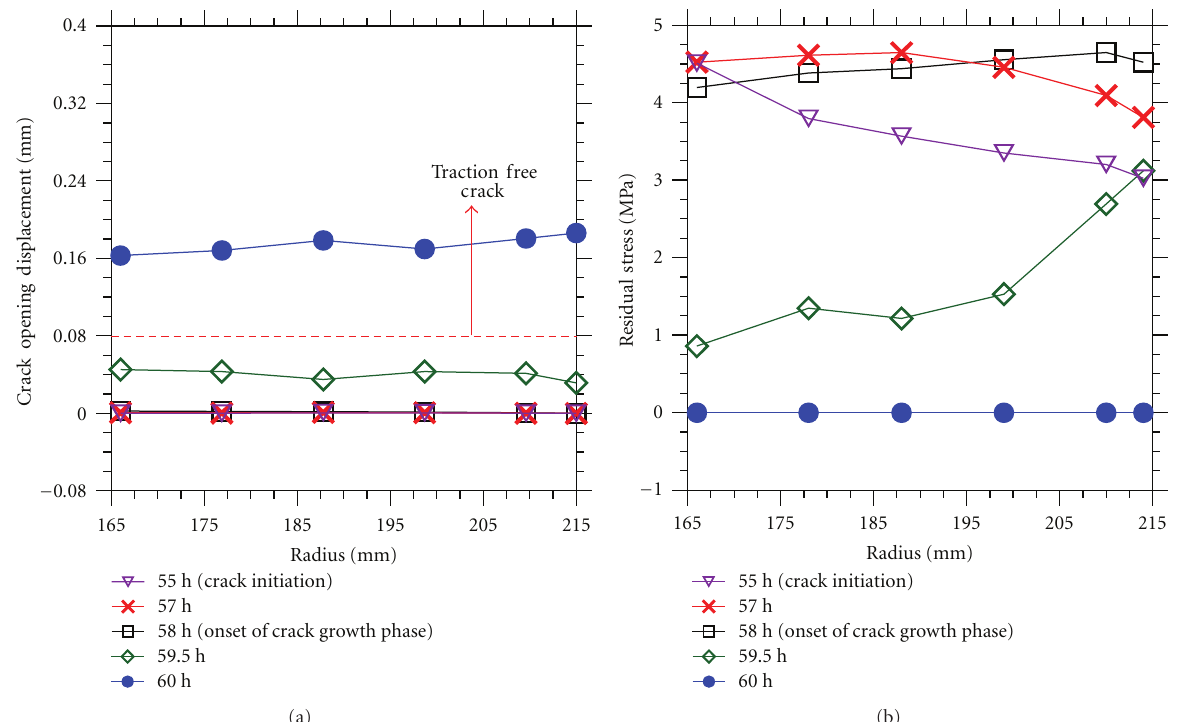
Figure 6: (a) Crack opening displacement and (b) average residual stress profile in the reduced strength section of the base case ring specimen when cooled at 48